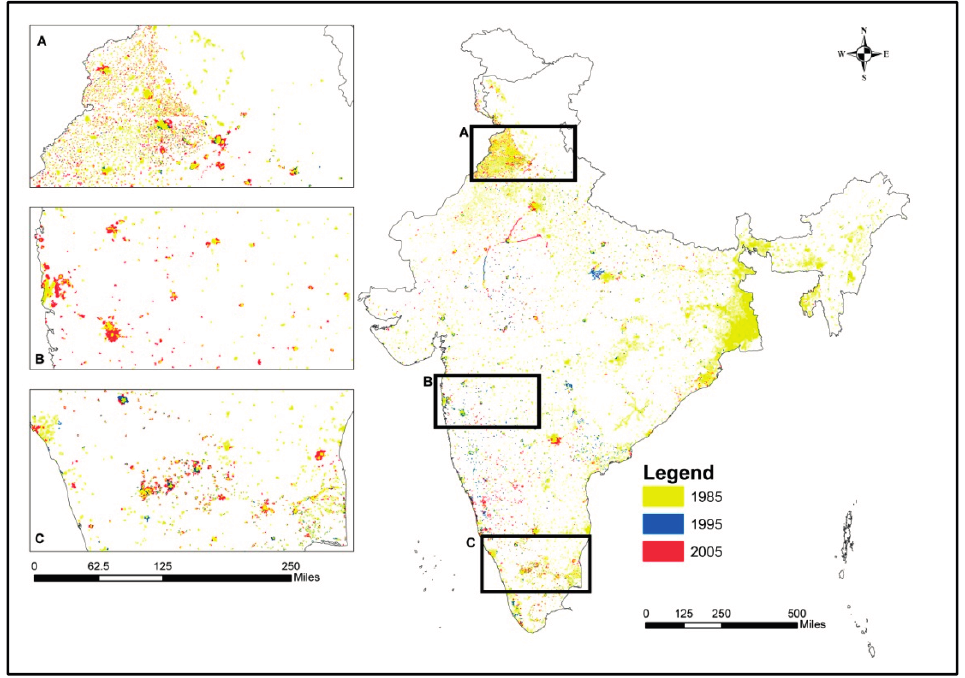
Figure 8. Map showing the urban growth during 1985 – 1995 – 2005. Major urban growth centers in north-west Punjab, western India around Mumbai region and Southern India are also